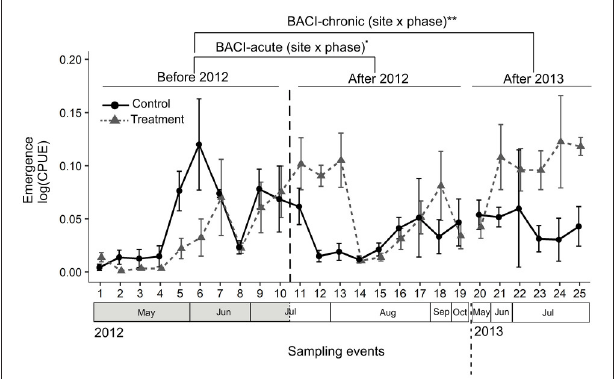
FIGURE 2 | Abundance of emerging aquatic insects (CPUE) was compared across sampling events within and among years using a BACI design. Control and Treatment sites were first compared prior to and during experimental illumination in 2012 (BACI-acute; Before 2012 and After 2012). Sites were then compared prior to illumination in 2012 with the same period of the year in 2013, after experimental illumination (BACI-chronic; Before 2012, After 2013). Significant site × phase interactions (GLS) are shown as ** p < 0.01; · 0.05 < p < 0.07. Means across all traps with standard errors are shown for the two sites at each sampling